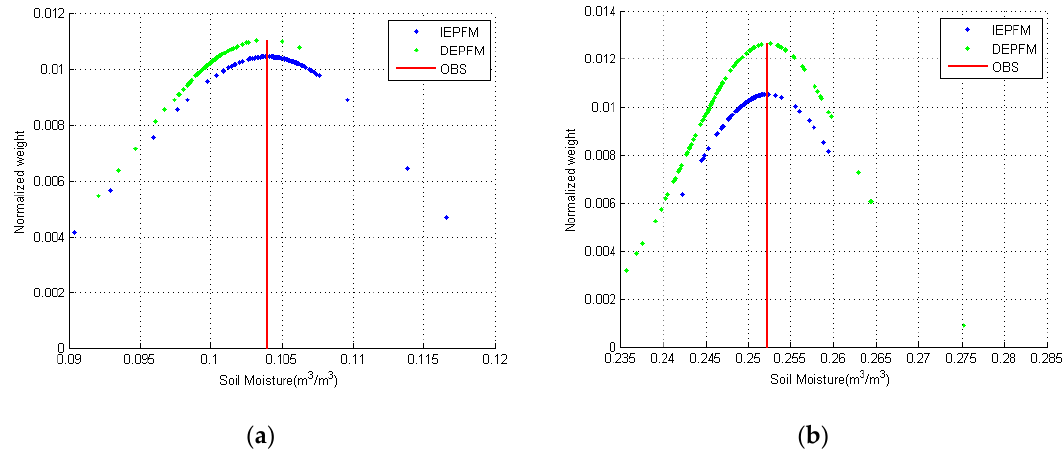
Figure 11. Comparison of the particle distribution and normalized weights produced by DEPFM and IEPFM on different assimilation days. ( a ) t = 45, ( b ) t = 70. The blue and green points present the particles generated by IEPFM and DEPFM, respectively. The corresponding SM of red line denotes the observation.